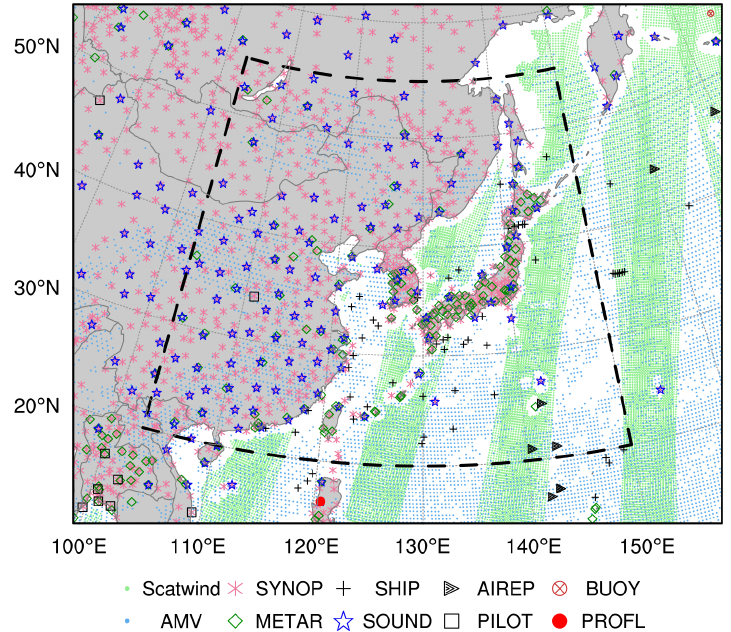
Figure 1. The East Asia Regional Reanalysis domain. The dashed black box denotes a verification area. Different types of NCEP PrepBUFR observations are available for assimilation at 00:00UTC on 1 January 2017. Table 1. Model